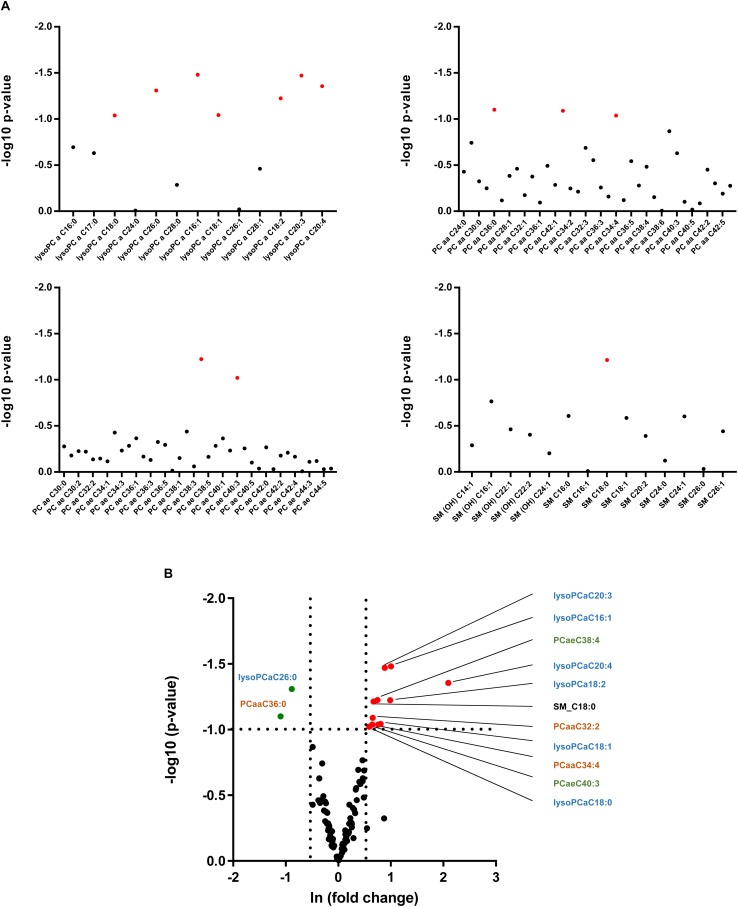
Lipid species in the serum of C57Bl6 and alb-SREBP-1 mice. (A) Alterations in individual lipid species in the group of phosphatidylcholines (PC), i.e., lysoPCs, PCaa, PCae, and sphingomyelins are indicated by log 10 p-value. Red dots indicate significant altered lipid species. (B) Differential abundance of lipid species. The fold change [(ln(fold change)] of lipid concentration was plotted against the significance (log 10 p-value). Red dots mark lipid species with >1.5-fold change in alb-SREBP-1c mice, green dots indicate lipid species with >1.5-fold difference in C57Bl6 mice. A p-value of <0.05 (Students’ t-test) was accepted as significant. Chemical residues [hydroxyl (OH), acyl (a), di-acyl (aa), and acyl-alkyl (ae)] are abbreviated accordingly. Nomenclature further indicates Cx:y (x, number of carbons in the fatty acid; y, number of double bonds in the fatty acid).